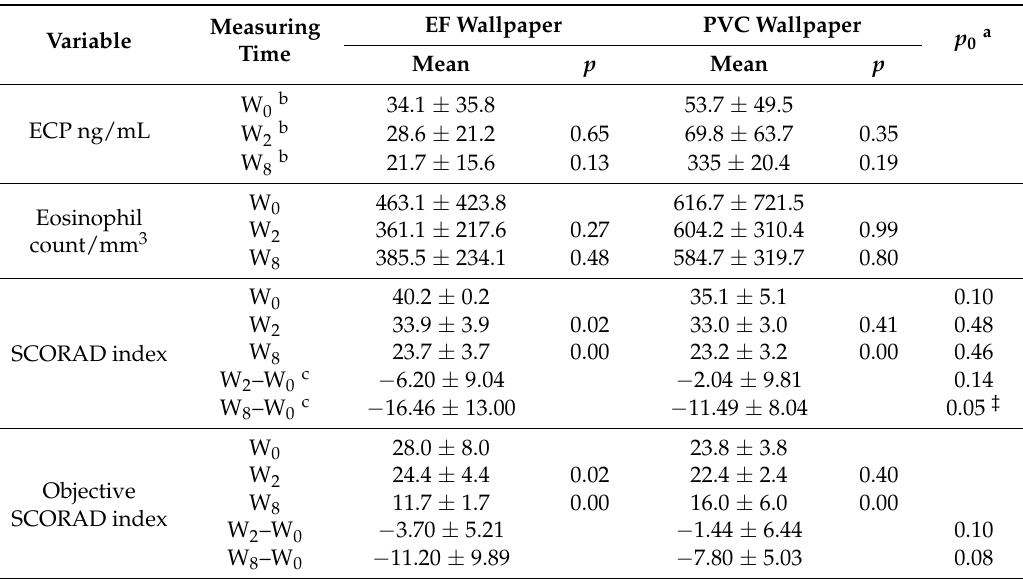
Table 6. Eosinophil count, eosinophil cationic protein concentration, and SCORAD Index before and after